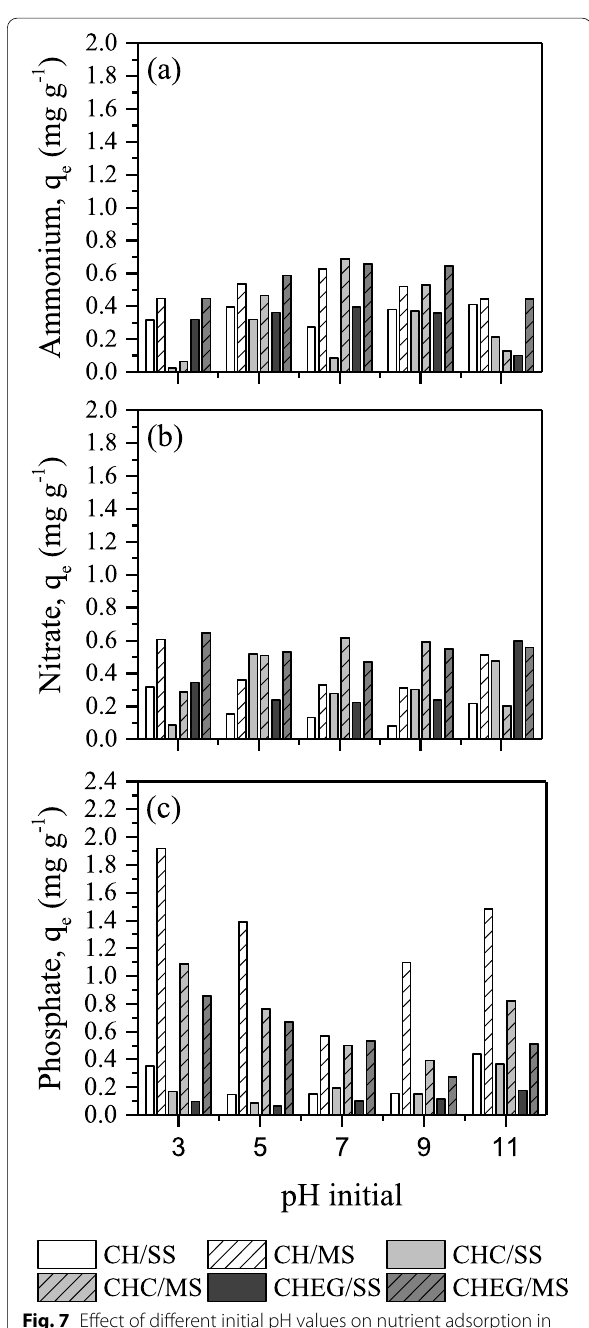
Fig. 7 Effect of different initial pH values on nutrient adsorption in single and mixed solute solutions; ( a ) NH 4 + adsorption; ( b ) NO 3 − adsorption; ( c ) PO 43 − adsorption (SS